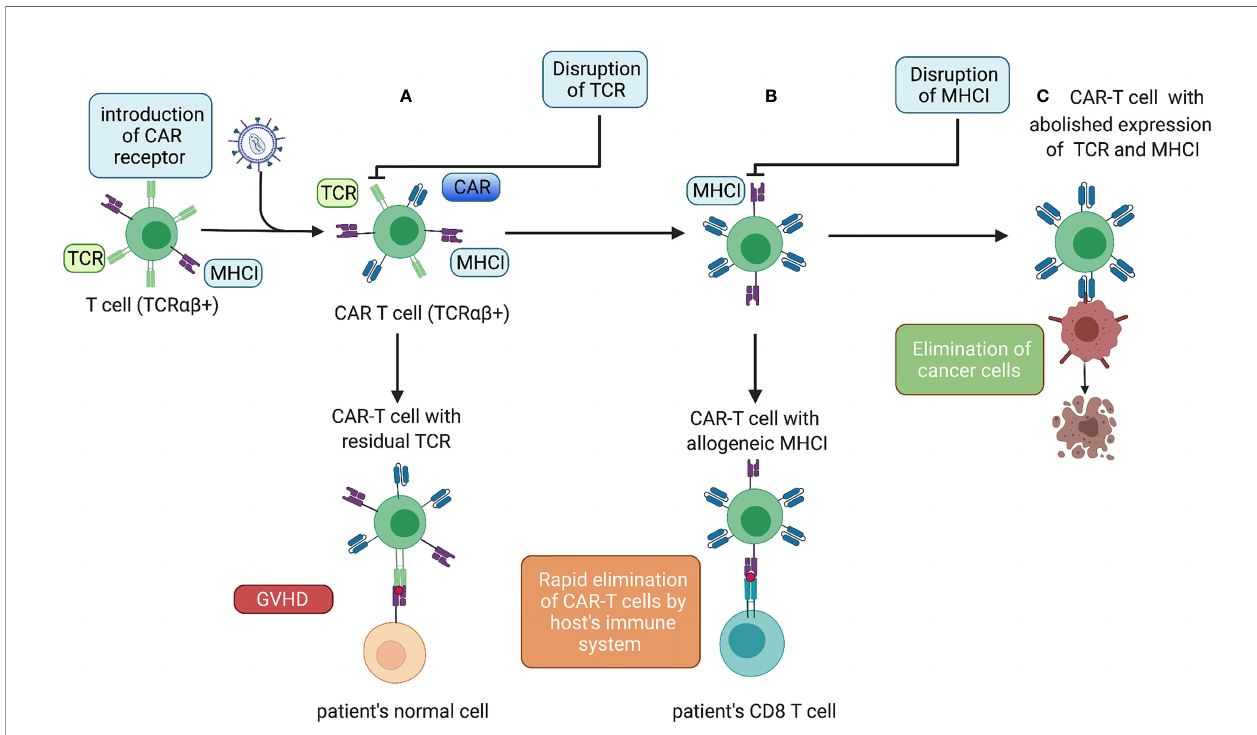
FIGURE 1 | Genetic modi fi cations of allogeneic CAR-T cells. (A) Lentiviral transduction of allogeneic T cells with a CAR. Donor CAR-T cells with allogeneic TCRs administered to a patient causing GvHD. (B) After an additional gene-editing step to disrupt TCR expression, the cells do not cause GvHD but can be eliminated rapidly by the host immune system. (C) The next gene-editing step abolishes expression of MHC-I molecules, thereby ensuring the prolonged endurance and persistence of allogeneic CAR-T